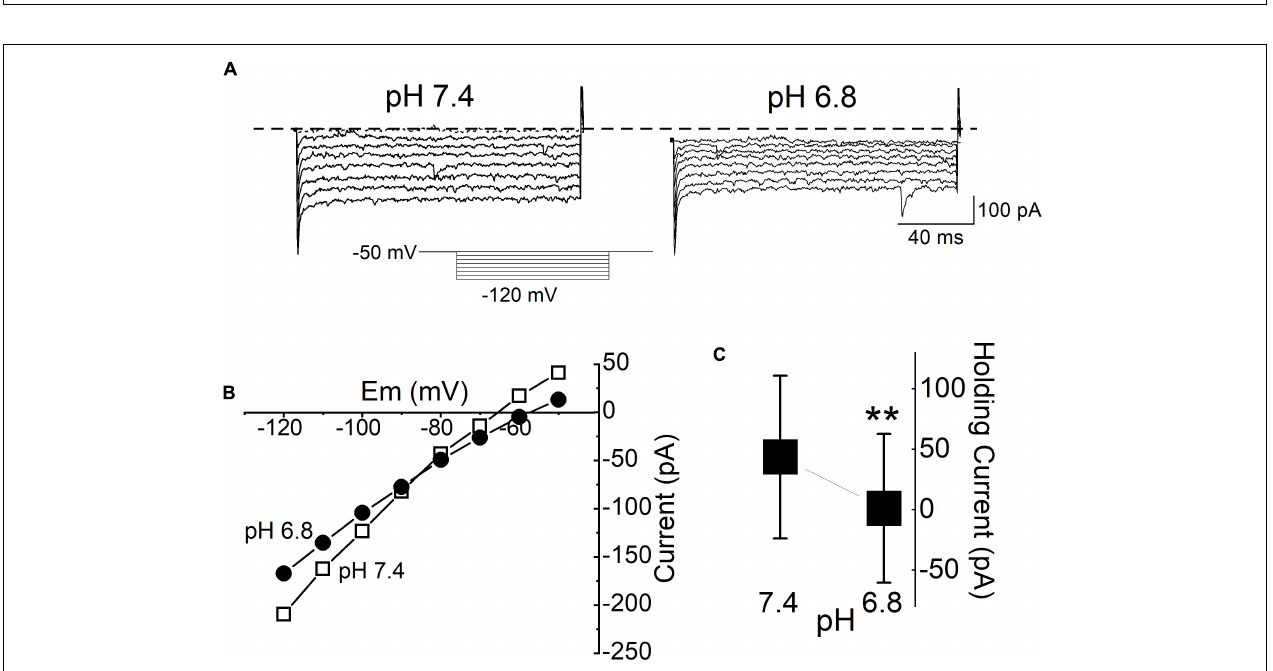
FIGURE 4 | SP inhibits background conductance. (A) Current traces from hyperpolarizing voltage steps applied in control conditions and during application of 0.1 to 1 µ M SP. Dashed lines indicate control potential. (B) The current-voltage (I-V) relation measured from the same cell in (A) . (C) Average baseline holding current recorded from cells in the control condition and during application of 0.01 to 1 µ M SP. ** P < 0.01. (D) Input resistance in the control and during application of 0.01, 0.1, and 1 µ M SP were 231.8 ± 74.9, 275.4 ± 93.1, 313.1 ± 109.9, and 337.2 ± 122.8 M (cid:127) , respectively ( n = 5).